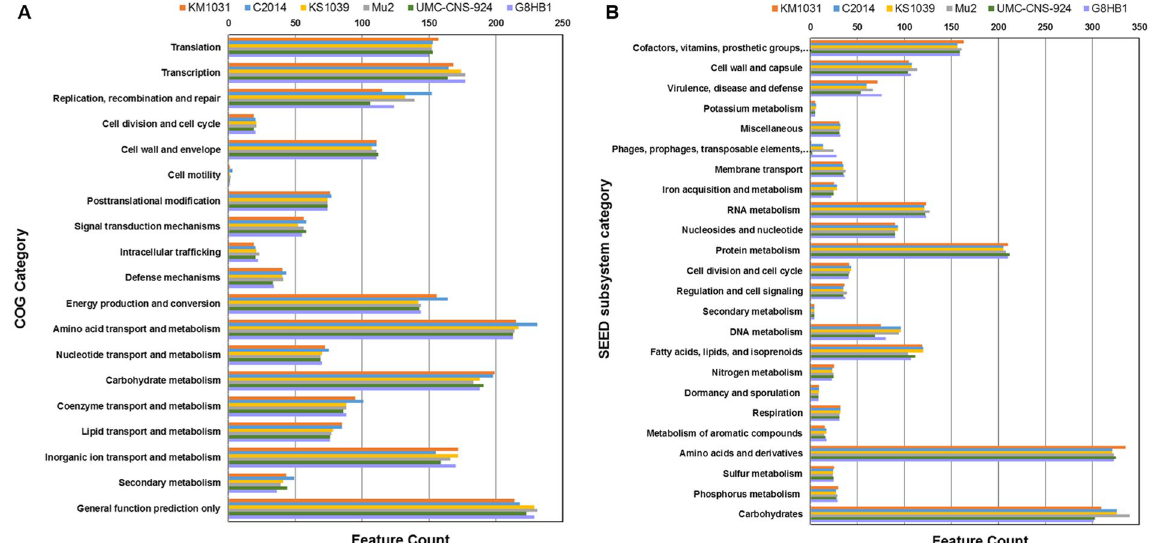
Figure 1. Comparison of functional categories in six S . equorum genomes based on COG ( A ) and SEED ( B ). Genome sequences of six strains KM1031, C2014, KS1039, Mu2, UMC-CNS-924 and G8HB1 were uploaded to the COG and SEED viewer servers independently. Functional roles of annotated genes were assigned and grouped in subsystem feature categories. Coloured bars indicate the number of genes assigned to each category.